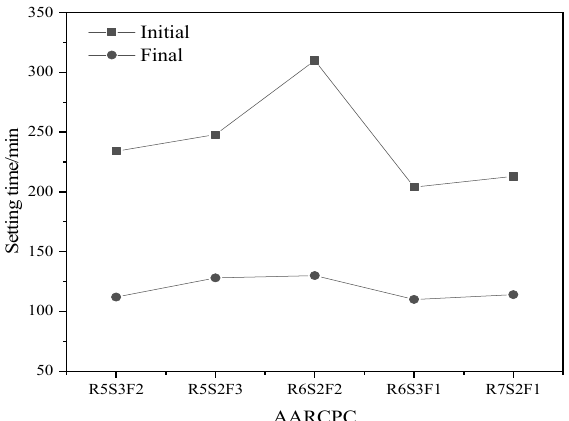
Figure 8. Setting time of AARCPC with composites composed of different fly ash and slag content.